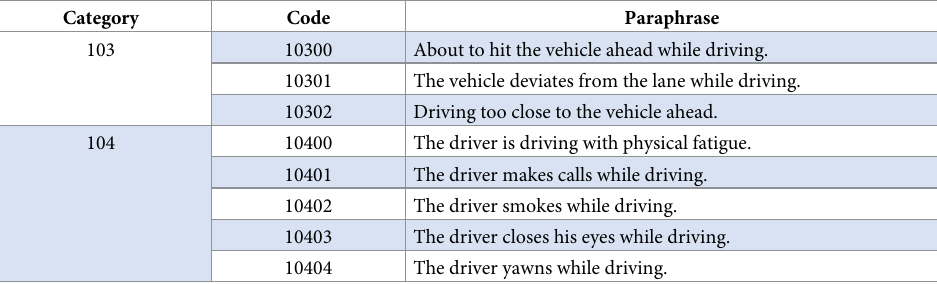
Table 4. Categories of distracted driving